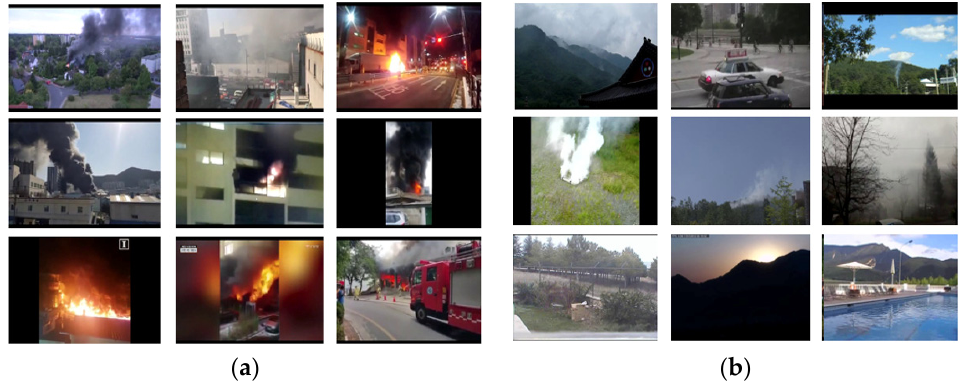
Figure 9. Sample still shots including flame, smoke, and non-fire objects take from video clips for LSTM training [26]. The ( a ) images are taken from videos of fire accident, while the ( b ) images are from non-fire video clips.